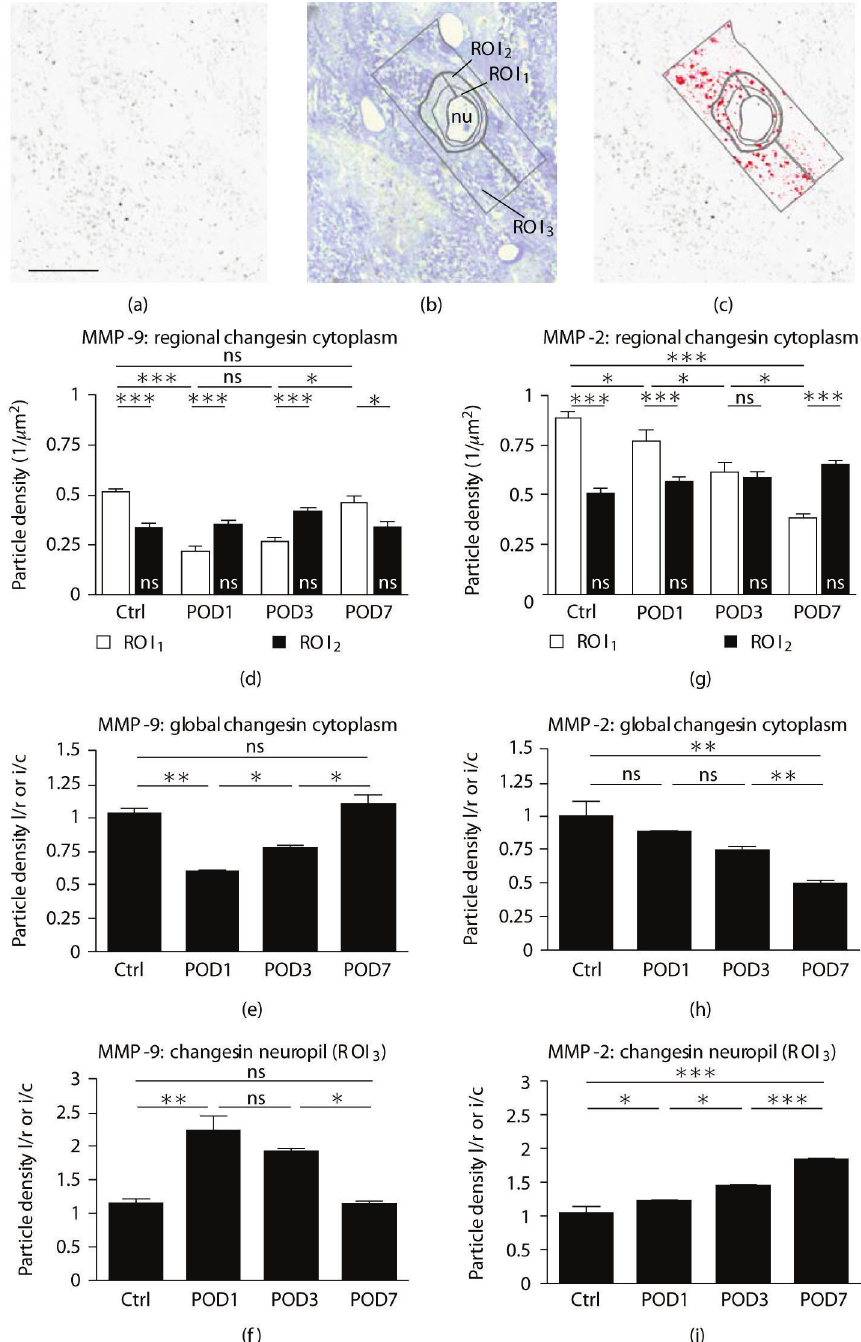
Figure 2: Semithin sections through AVCN stained for MMP-9 and MMP-2 immunoreactivity following cochlear ablation, and their quantitative evaluation. (a) By POD7, MMP-2 immunoreactivity showed up as particles. (b) Counterstaining of the same section with methylene blue, visualizing cellular boundaries. Lines indicate the regions of interest (ROI) sparing the cell nucleus (nu). (c) Same section as in (a) with the superimposed ROIs. Particles detected by computer-aided image analysis are indicated in red. Scale bar for (a)–(c) 20 μ m. (d) Subcellular redistribution of MMP-9 immunoreactive particles in AVCN neurons in control animals (ctrl) and at POD1, 3 and 7 following cochlear ablation. Bars indicate particle density in ROI 1 and ROI 2 . ns designates insignificant changes within ROI 2 at any time. (e), (f) Changes in MMP-9 particle density in cytoplasm (e) and neuropil (f) of AVCN neurons in controls (ctrl) and by POD1, 3 and 7 following cochlear ablation. Bars indicate left-to-right (l/r) or ipsilateral-to-contralateral (i/c) ratio of particle density. (g) Subcellular redistribution of MMP-2 immunoreactive particles within the cytoplasm of AVCN neurons in control animals (ctrl) and by POD1, 3 and 7. (h), (i) Changes in MMP-2 particle density in cytoplasm (h) and neuropil (i) of AVCN neurons in control animals (ctrl) and by POD1, 3 and 7 following cochlear